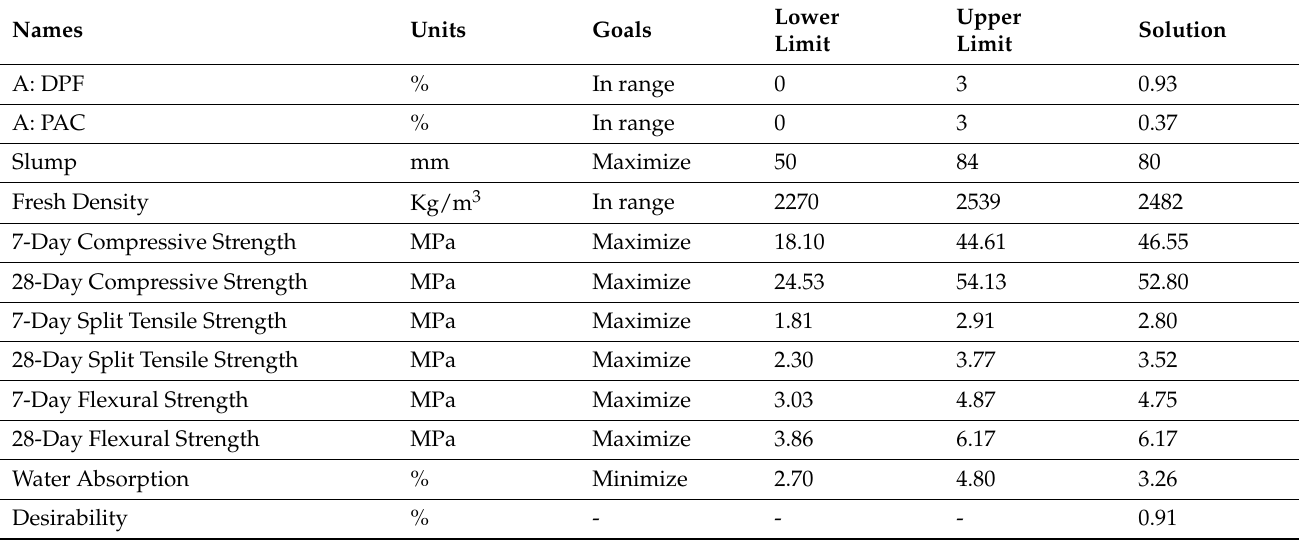
Table 12. Goals and results of multi-Objective optimization.